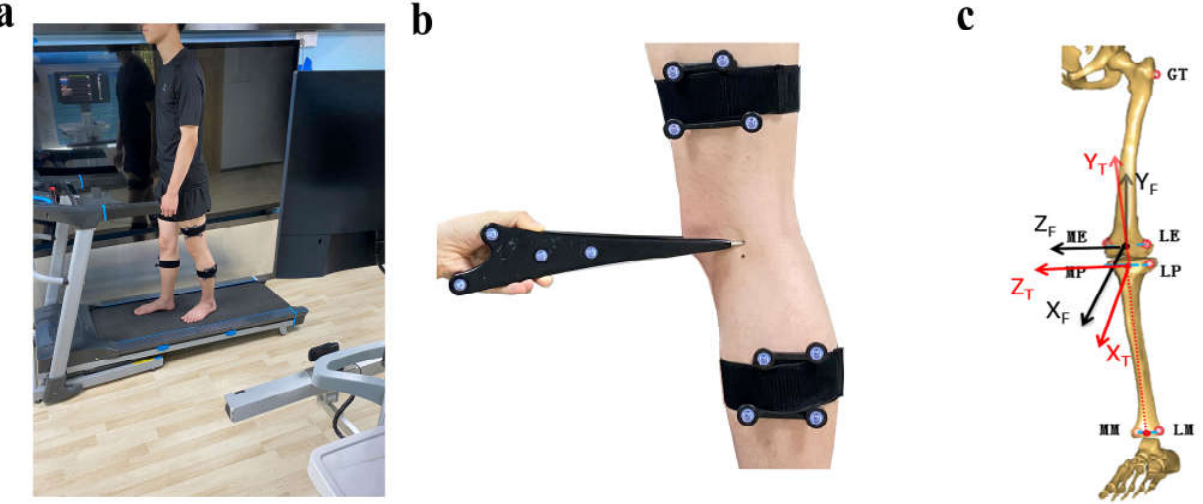
Figure 3. Diagram of the knee kinematic analysis system. ( a ) The scene of the kinematic analysis system capturing knee kinematic data; ( b , c ) the knee kinematic analysis system sets up a persionalized 3D coordinate systems of the tibia and femur.